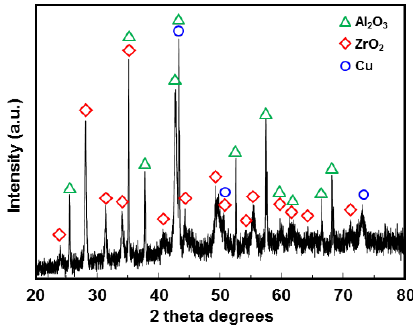
Figure 10. X-ray diffraction (XRD) pattern for an inter-diffusion layer at the interface between α -Al 2 O 3 and Cu-7Al-3.5Zr showing that the presence of ZrO 2 is evident at the interface. It should be noted that the reaction layer consists of ZrO 2 oxide and α -Cu alternating between these two phases. In contrast, the interfacial microstructure using a Ti-containing brazing filler metal has continuous and flat Ti 2 O or Ti 3 Cu 3 O reaction layers at the Al 2 O 3 interface [14,27]. This difference is considered to be because that Ti-containing alloys has better wettability with the lower contact angles on the Al 2 O 3 rather than Zr-containing one [18]. Also, the alternative structure of ZrO 2 + Cu layer can be properly explained by the differences in density between Cu and ZrO 2 . The densities of ZrO 2 and Cu were 5.7 and 8.96 g · cm − 3 , respectively [20], which could account for the buoyant forces at the reaction front. It is considered that ZrO 2 adjacent to the α -Al 2 O 3 surface was transported away from the reaction front due to the differences in density of Cu and ZrO 2 and separately aggregated